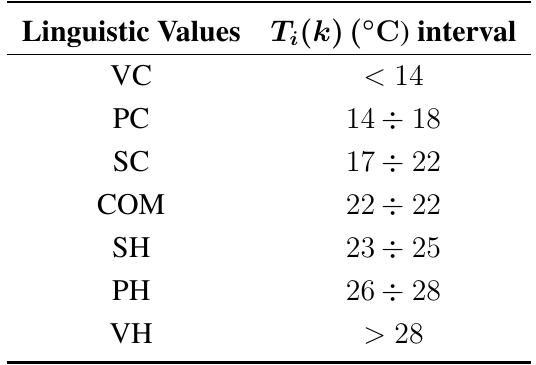
for the winter scenario. i